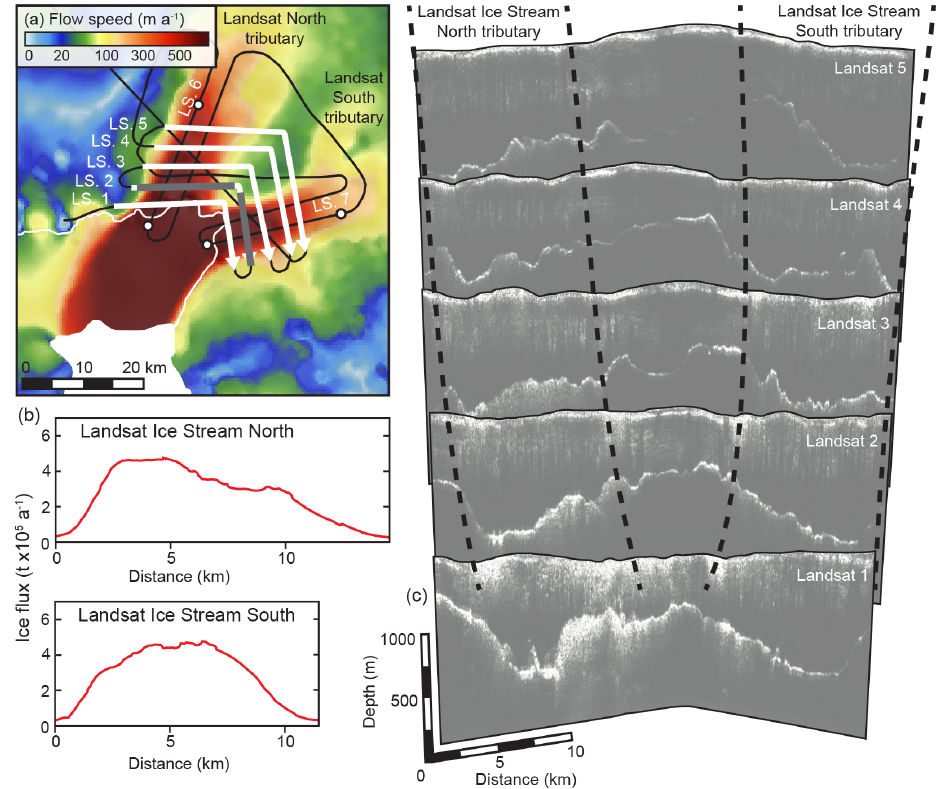
Figure 6. Landsat Ice Stream is fed by northern and southern tributaries, which coalesce at the grounding zone. These discrete flow units are clearly visible in panel (a) which shows a map of surface flow speeds from Mouginot et al. (2019a). Black lines show the density of RES transects in this location, whilst white arrows show the location and orientation of transects displayed in panel (c) . In panel (a) the white line represents the ASAID grounding line (Bindschadler et al., 2011) whilst thick grey lines show the location of flux gates, presented in panel (b) . White circles in panel (a) represent the extent of along-flow radar transects presented in Fig. 7 (where sea level is marked along each tributary). Radargrams in panel (c) show how the two ice stream tributaries (approximately marked by a black dashed line) are separated by relatively high-elevation subglacial